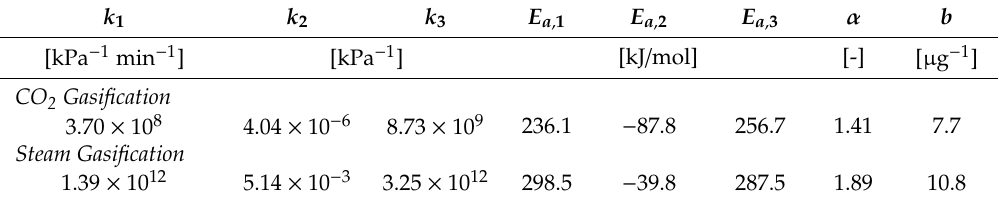
Table 6. Results for the L–H reaction model with the Johnson conversion